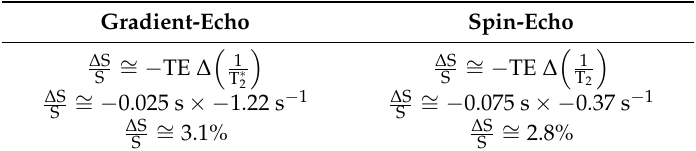
Table 1. Estimate of relative BOLD signal changes (percent change from baseline) with gradient-echo and spin-echo methods at optimal echo